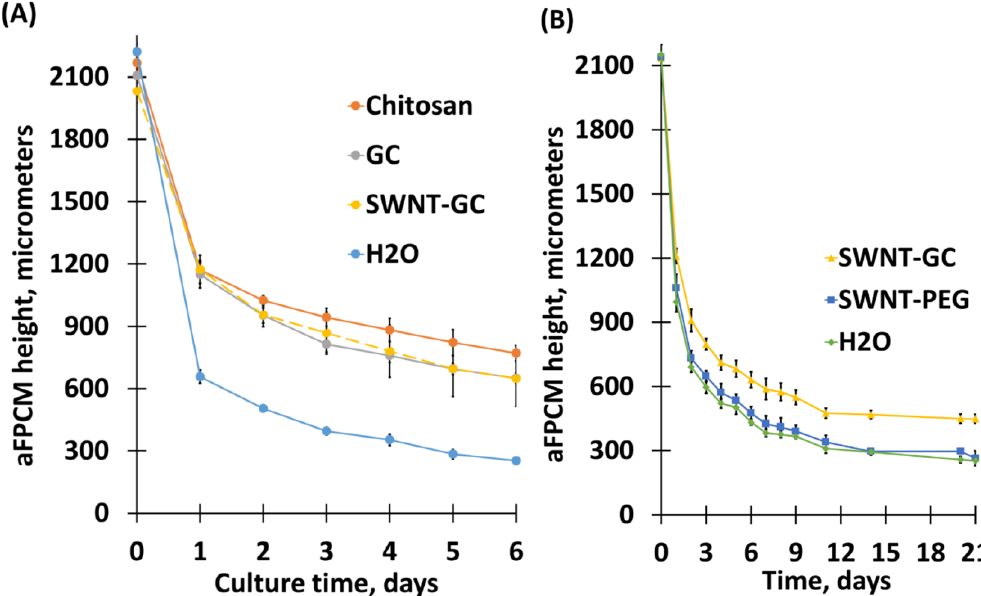
Figure 1. ( A ) Chitosan (C) derivatives reduced compaction of aFPCM over a 6-day period. Cells were cast in aFPCM incorporated with either water, C, GC, or SWNT-GC. Compaction was measured once daily for 6 days. The control (H 2 O) means were significantly different (SD) ( p < 0.05) than C and GC means at days 1–7. ( B ) SWNT-PEG did not reduce compaction of aFCPM. The control means were SD